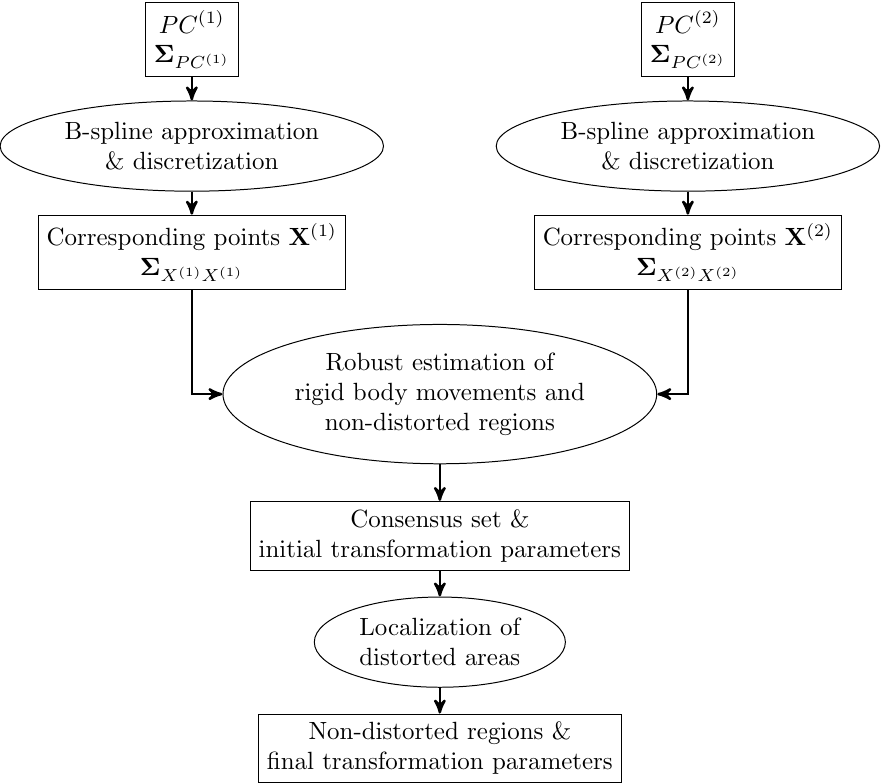
Figure 3. Flow chart of the developed procedure